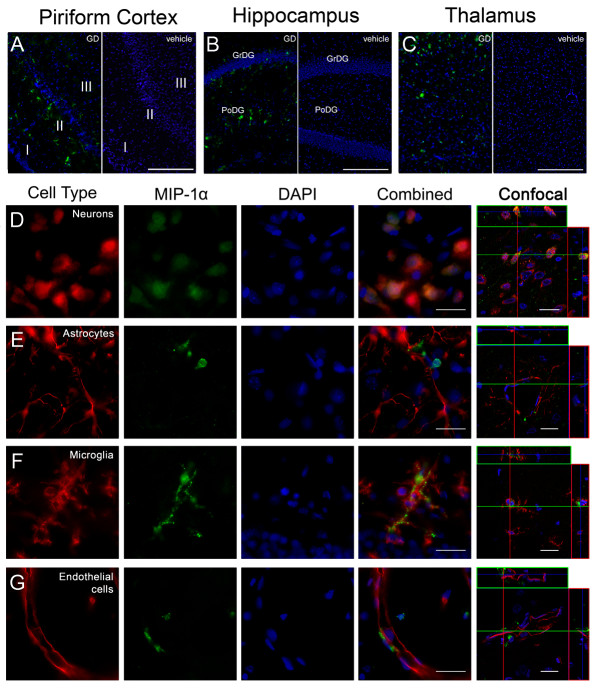
MIP-1α is primarily expressed by neurons and dystrophic microglia after GD-induced SE. MIP-1α immunolabeling (A-G, green) is present in the piriform cortex, hippocampus and thalamus 12 hours after GD-induced SE (A, B & C; left) but absent in vehicle controls of these same regions (A, B & C; right). In the piriform cortex (A), labeling is observed primarily in layers II and III. In the hippocampus (B), labeling was less robust and found primarily in the CA1 and CA3 pyramidal layers as well as in the polymorphic layer of the dentate gyrus (PoDG) but not the granular layer of the dentate gyrus (GrDG). MIP-1α labeling was also less robust in the thalamus (C) and was found primarily in the laterodorsal and lateral posterior nuclei. Neurons (D, red) and MIP-1α frequently co-localized (D, yellow), while no co-localization with astrocytes (E, red) was observed. MIP-1α was primarily expressed by microglia with a dystrophic morphology (F, red). Limited co-localization was observed in endothelial cells (G, red). Scale bar: 250 μm (A-C), 50 μm and 10 μm (D-F) for regular and confocal fluorescent microscopy respectively; n = 9 for 12-hour and n = 4 for vehicle controls.